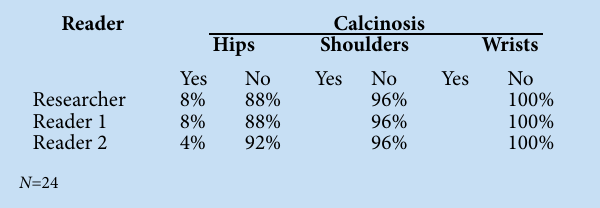
Table II. Assessment of calcinosis in hips, shoulders and wrists by each reader and